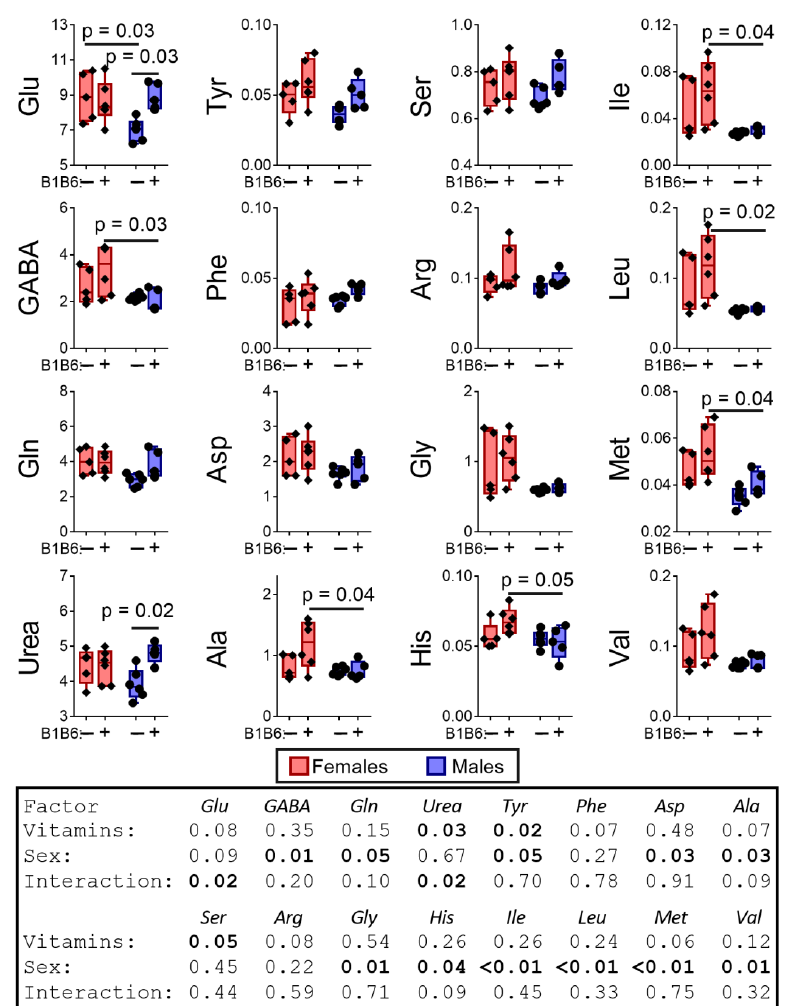
Figure 6. Effects of the administration of vitamins B1 and B6 to the PTZ-treated animals on the levels of amino acids and urea in the cerebral cortex of the male and female rats the next day after the PTZ-induced seizure. The metabolites are indicated on the Y axes, their content is expressed in micromoles per g of tissue. The statistical analysis of the data was performed by the two-way ANOVA with Tukey ’ s post hoc test (see Section 4).